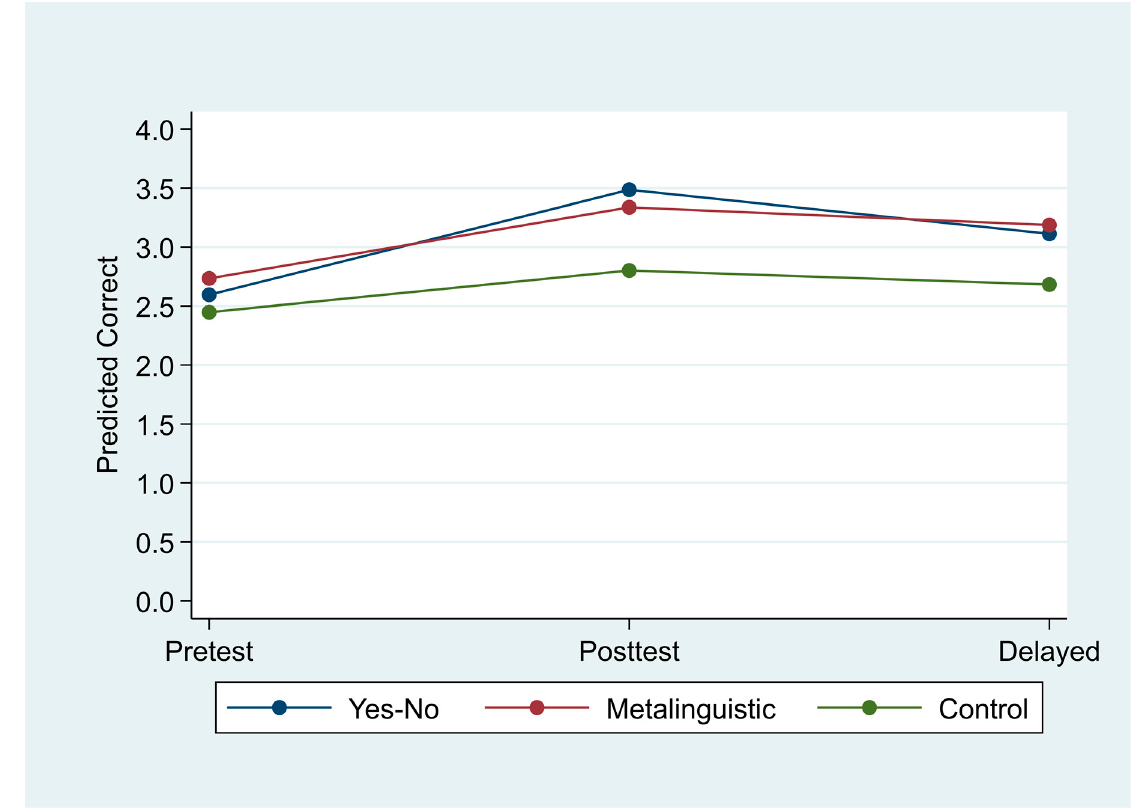
Figure 7. Predicted Probability of Accurate Interpretation in the Subject-Preterite Condition by Group and 1